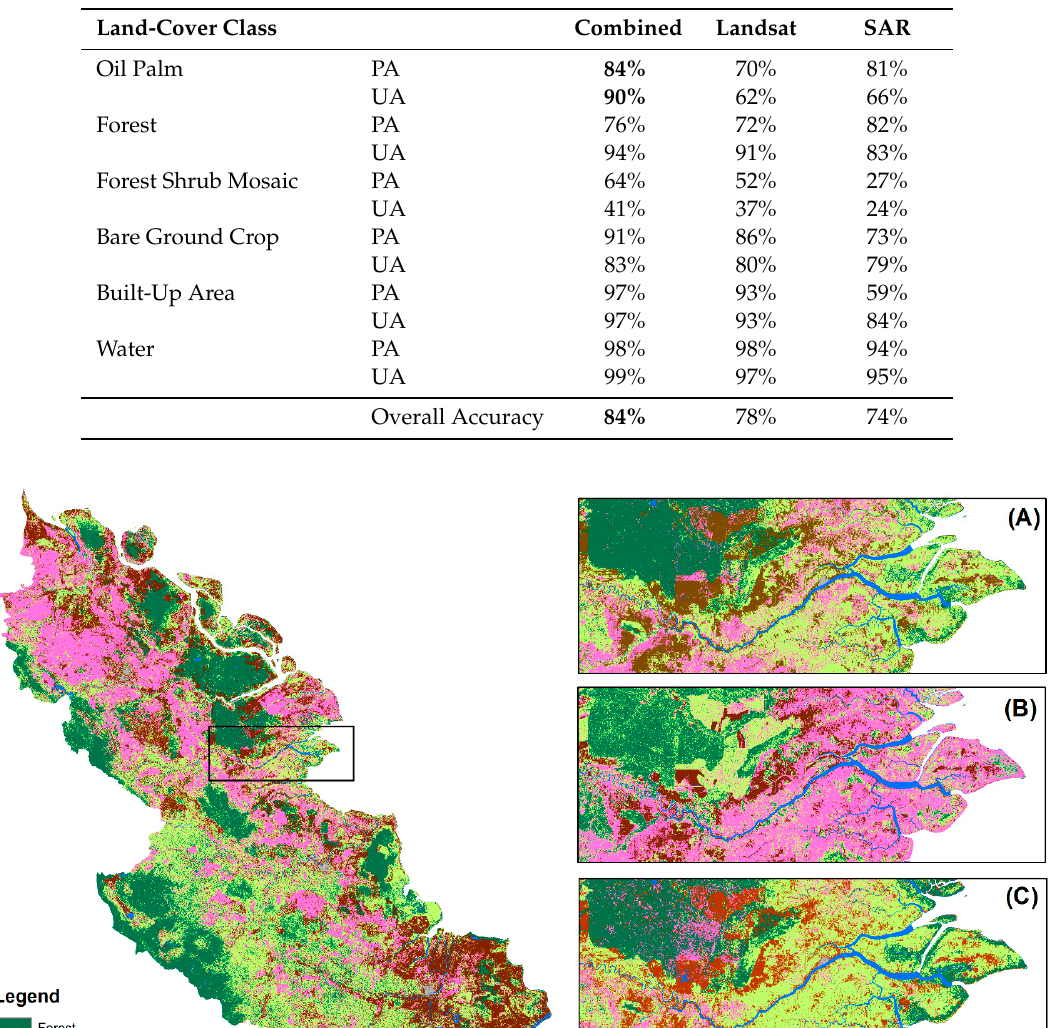
Table 3. Producer’s (%) and user’s (%) accuracy of Combined, Landsat, and SAR classified maps for all land-cover classes. Producer’s accuracy (PA); user’s accuracy (UA). Values in bold represent the highest producer’s and user’s accuracy for oil palm land-cover and highest overall accuracy.